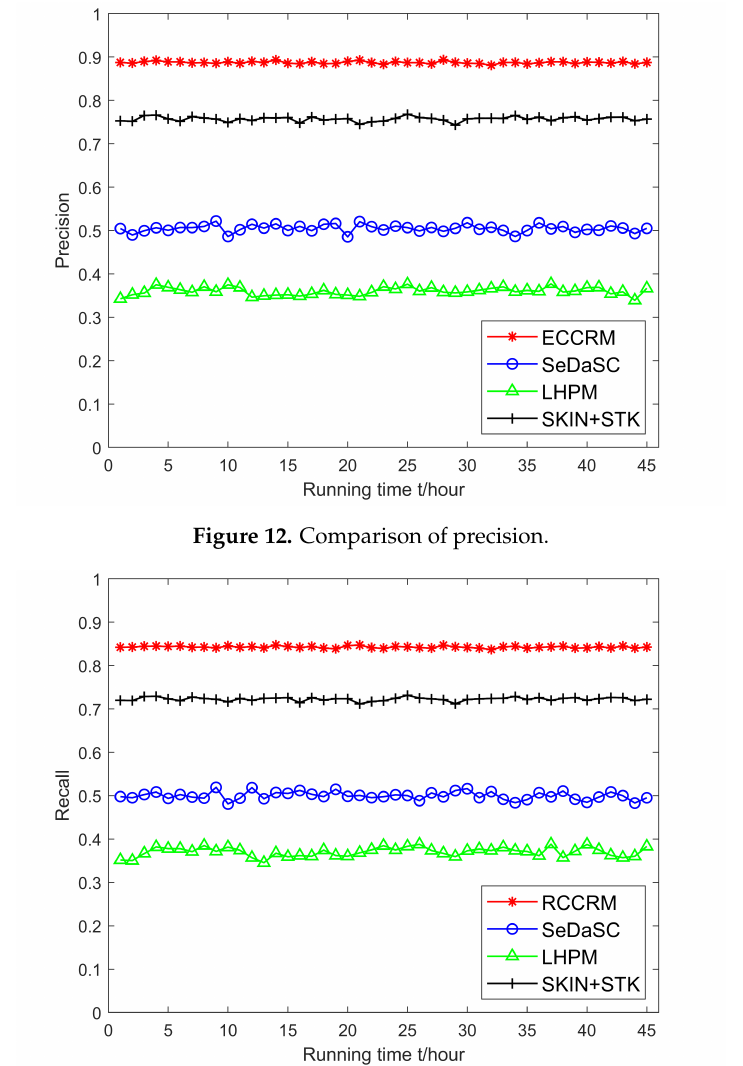
Figure 13. Comparison of